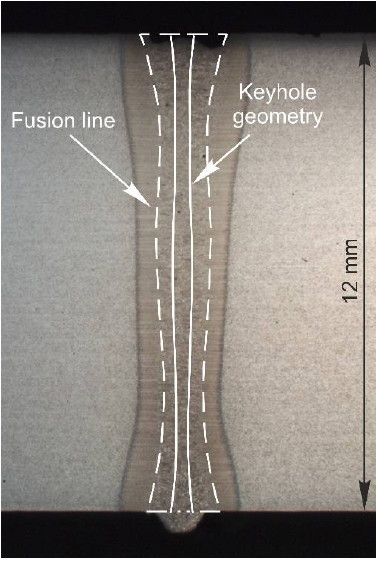
Figure 4. Cross-section of the weld and the used keyhole geometry in the CFD model.